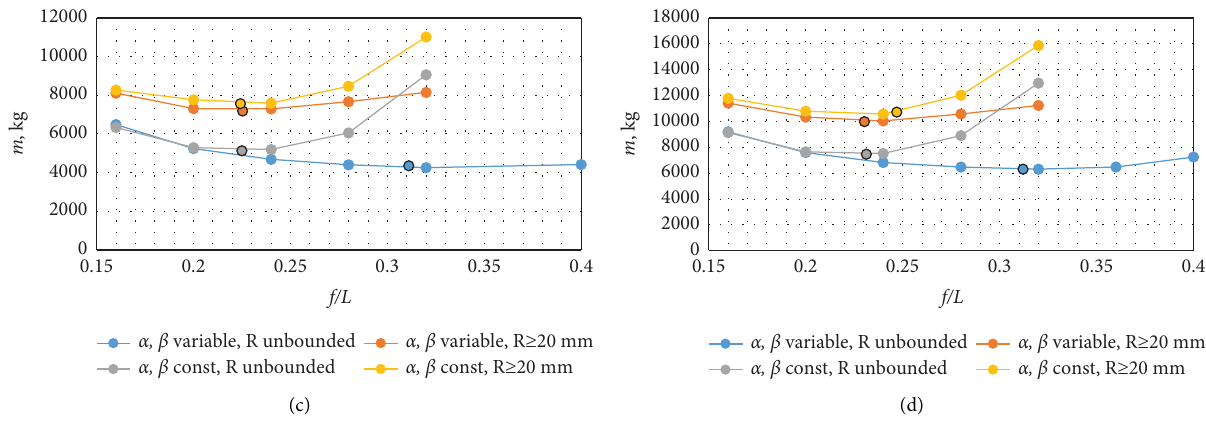
Figure 8: Dependency of total bridge mass to fxed ratio f / L : (a) 30m span, (b) 60 m span, (c) 75 m span, and (d) 90 m span.